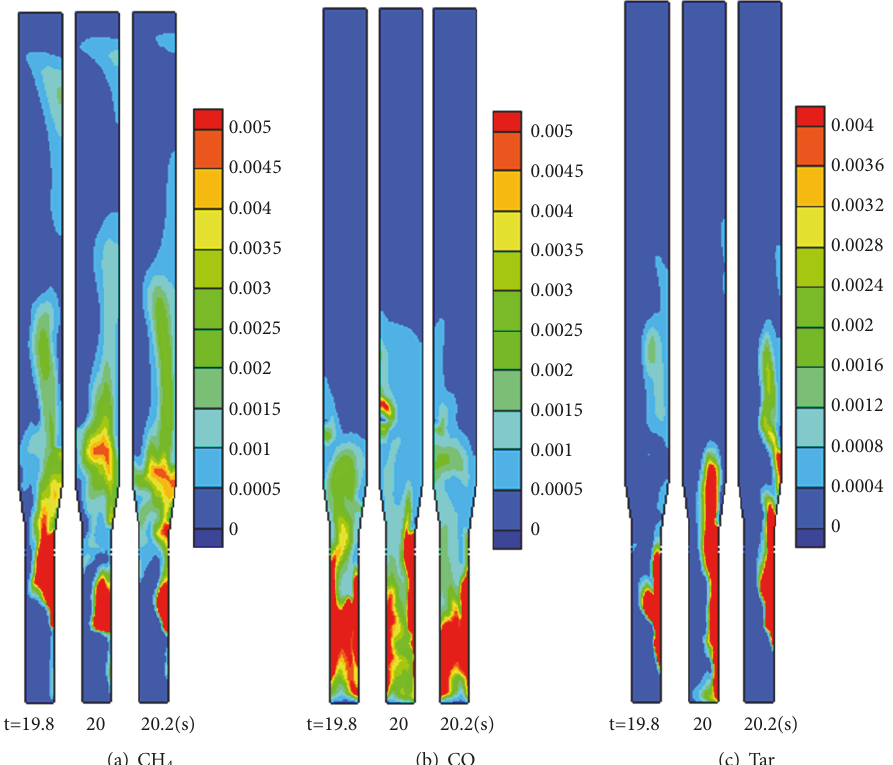
Figure 11: The contours of the instantaneous mass fractions of the main volatile species.